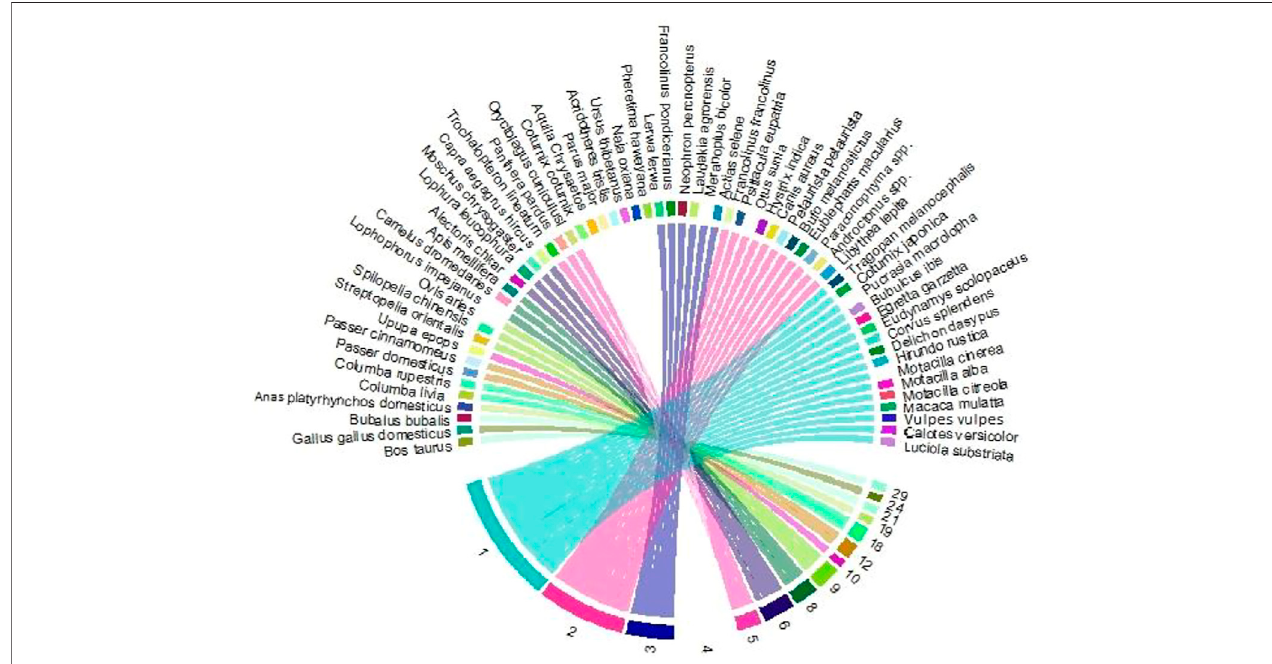
FIGURE 7 | The relationship between the FC and the number of species application in Haveli districts.